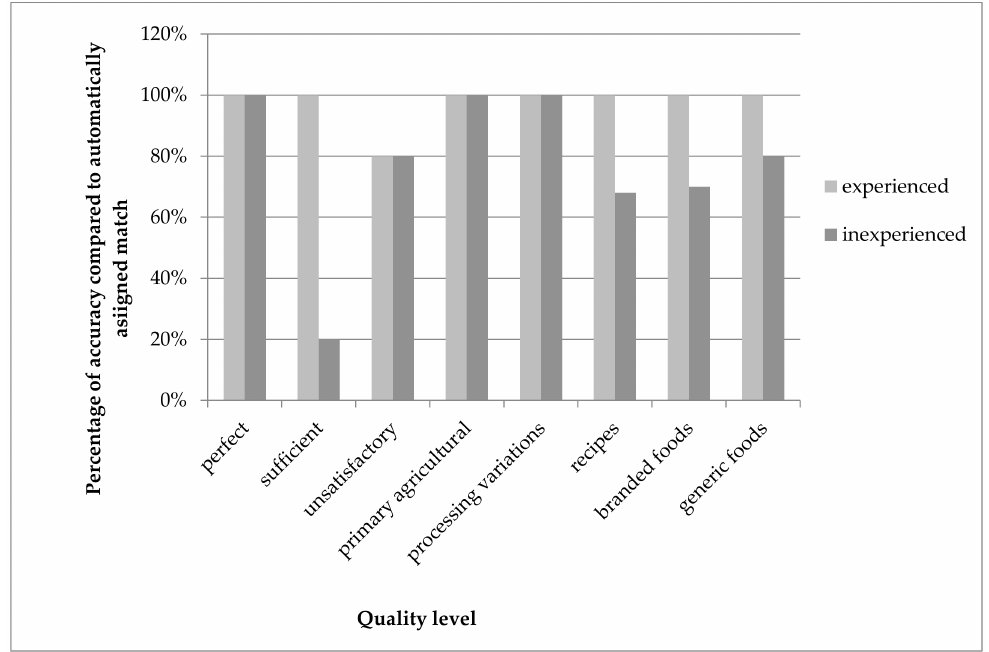
Figure 9. Percentage accuracy compared to the expected match for an experienced and an inexperienced human expert (results for